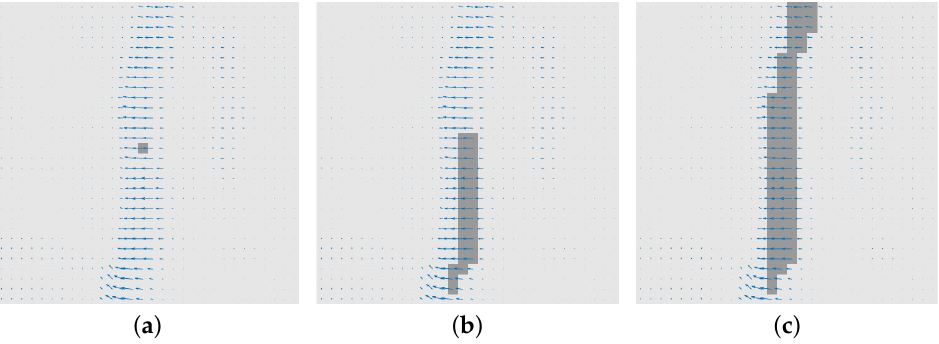
Figure 5. Process of SRMSD. The arrow represents the gradient direction and the length represents the gradient strength. ( a ) Selection of the seed pixel. ( b ) Iterative process of SRMSD. ( c ) Results of